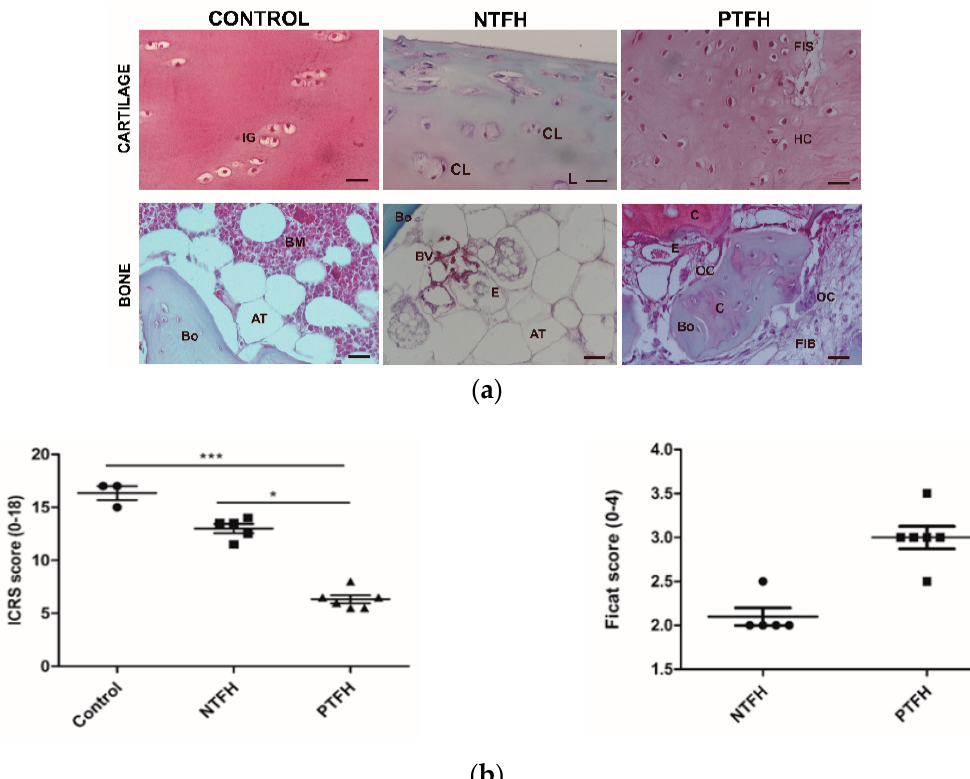
Figure 1. ( a ) Safranin-O / Fast Green staining of cartilage and subchondral bone from healthy controls, and two groups of patients with non-traumatic femoral head (NTFH) ON ( n = 5), and post-traumatic femoral head (PTFH) ON ( n = 6). Red: proteoglycans; green: collagen. Scale bar: 50 µ m. IG isogenic groups: CL cell clusters; L: empty lacunae; FIS fibrillation processes; HC hypertrophic chondrocytes; T tears; Bo bone tissue; BM bone marrow; AT adipose tissue; BV blood vessels; FIB fibrous tissue; OC osteoclasts; E erythrocytes. ( b ) Graphical representation of ICRS and Ficat scores of the osteochondral unit of control, NTFH and PTFH groups. Data are reported in a scatter plot graph with mean ± standard deviation (SD). * p < 0.05: NTFH versus PTFH; *** p < 0.001: PTFH versus the control group.